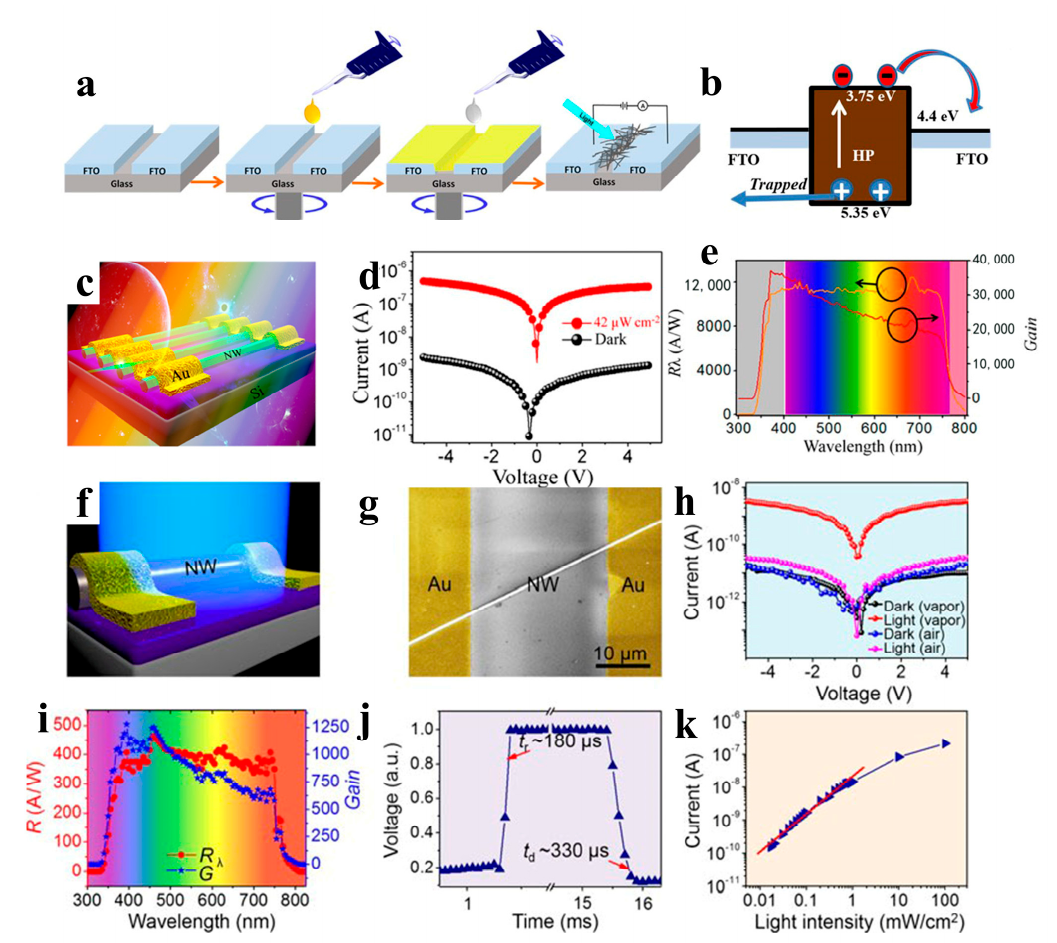
Figure 13. ( a ) Two‑step all‑solution synthesis of NW‑based PD. ( b ) Energy band alignment of the HP and FTO films in a device under illumination. Reproduced with permission from reference [111].